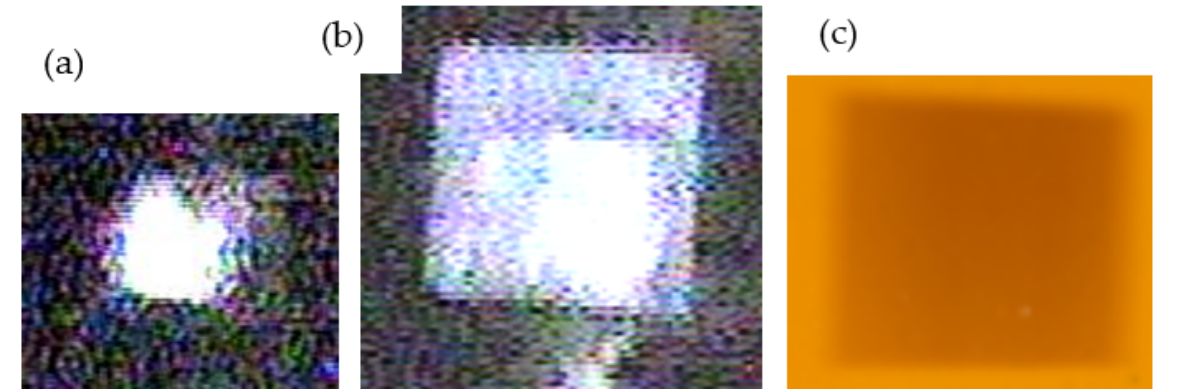
Figure 7. ( a ) Stationary 10 MeV Fe +4 160 nA ion beam spot at fused quartz; ( b ) The same Fe +4 ion beam “wobbled” over irradiation area 15 × 15 mm 2 (lighter part of the image is a result of reflection of illumination light); ( c ) Darkening of Kapton foil with the same “wobbled” Fe +4 ion beam shown in the same scale.